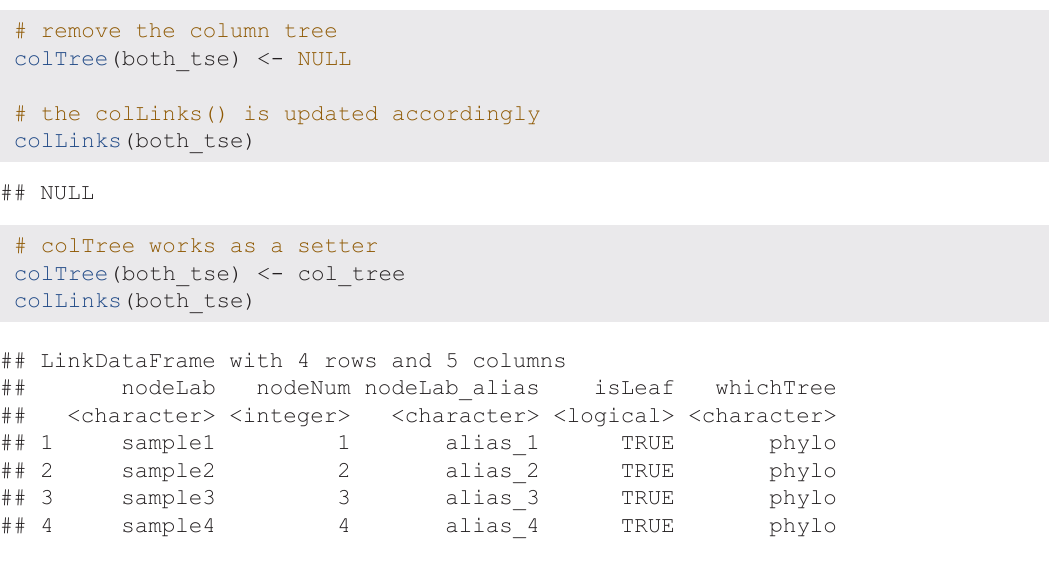
The subsetting function A TreeSummarizedExperiment object can be subset in two different ways: to subset by rows or columns, [ and to retrieve row and/or columns that correspond to nodes of a tree. As the numeric ID of subsetByNode a node changes with the cut of a tree, to keep track of the original data, we do not prune the tree struc- phylo ture in the subsetting. Below, we can see that and are updated to have the same number of rowLinks rowData rows as assays